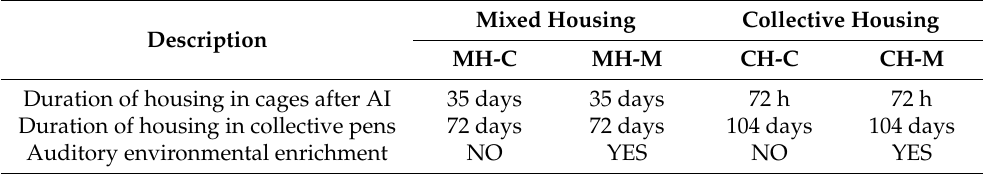
Table 1. Treatments used in the